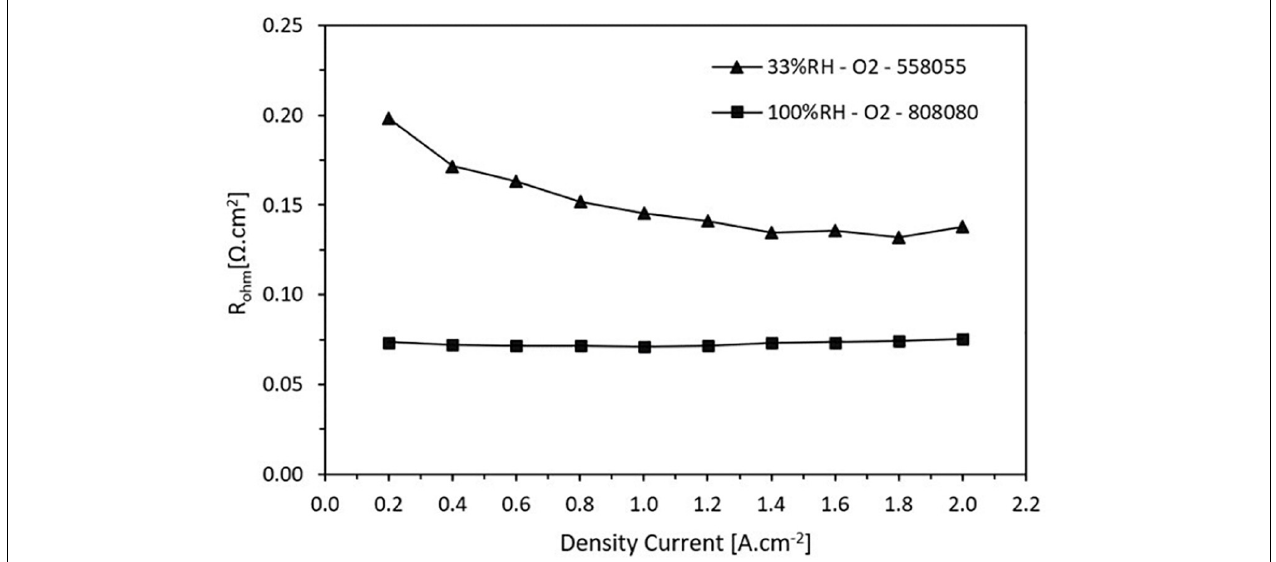
FIGURE 7 | Ohmic resistance trend in function on the current density for high and low relative humidity.